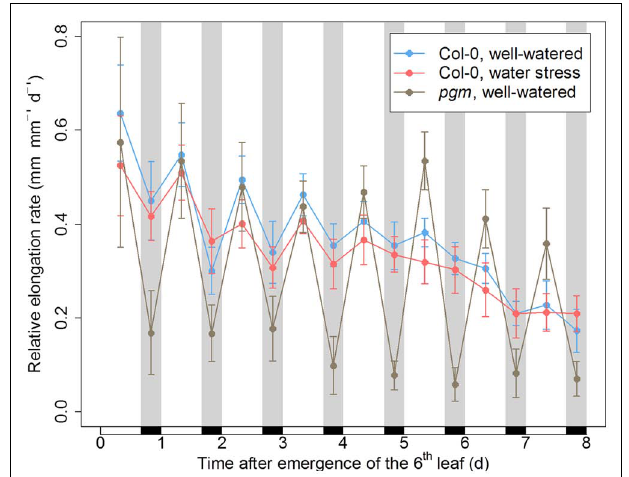
FIGURE 2 | Day/night pattern of leaf growth in Arabidopsis plants with a disturbed hydraulic or metabolic status. The relative elongation rate of the sixth leaf was monitored for 8 days following its emergence in the wild-type Col-0 under well-watered conditions or under moderate soil water stress (predawn water potential of –0.7 MPa), as well as in the starchless mutant pgm under well-watered conditions. Black rectangles and gray bands indicate the night periods. Error bars are 95% confidence